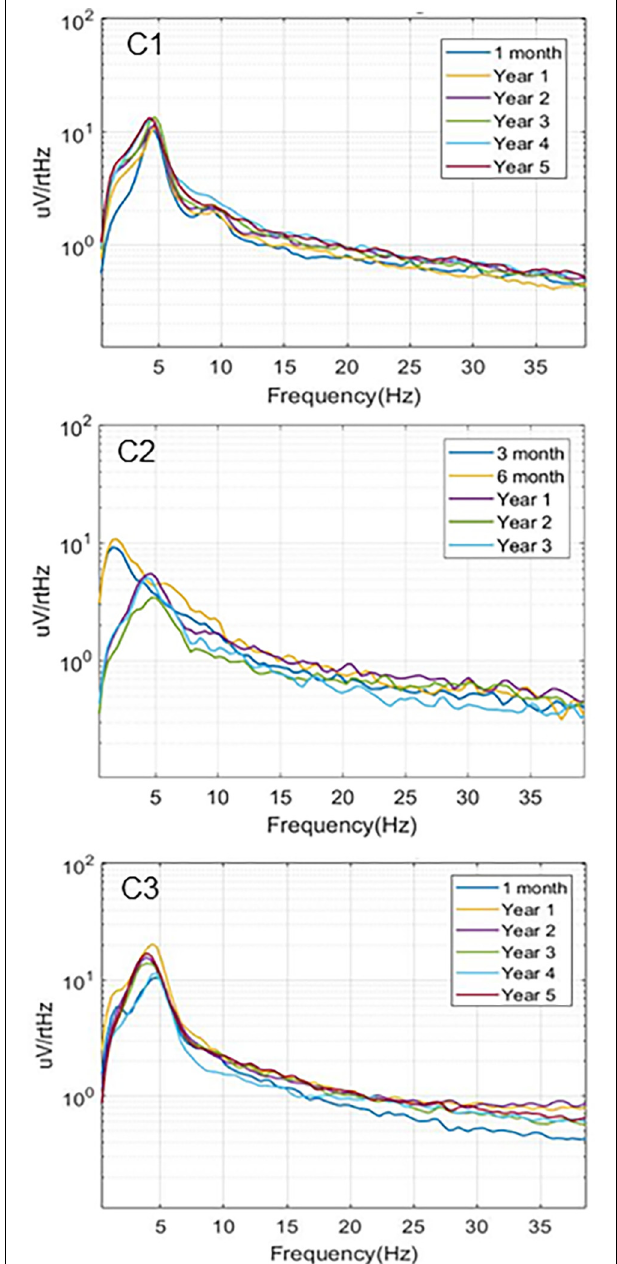
FIGURE 4 | Local field potentials. Representative examples of hippocampal LPF power spectra recorded over the study period for the three subjects. C1 (HC E0-E3) and C3 (HC E0-E3) recordings exhibited predominant theta activity. Initial recordings from C2 (HC E1-E3) contained mainly sharp wave activity while later recordings from a different electrode pair (HC E0-E3), due to lead breakage, were more theta dominant.